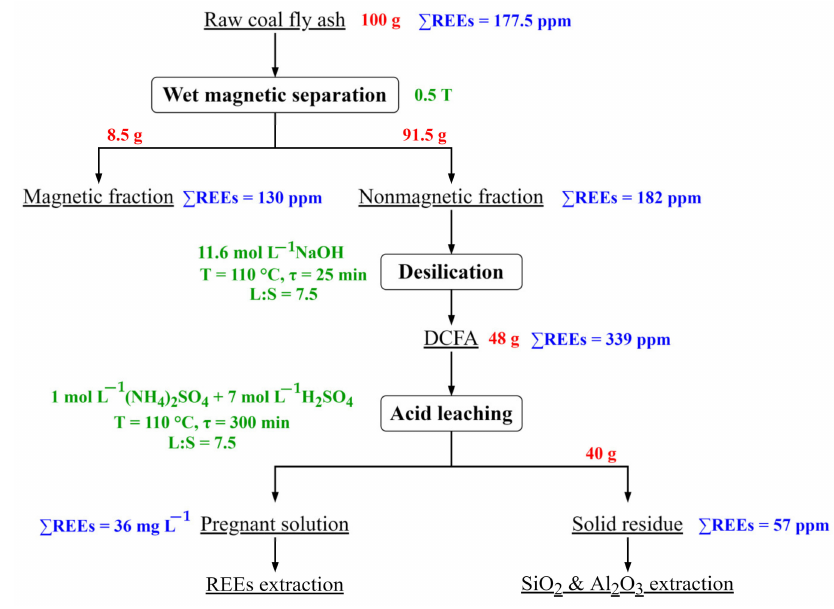
Figure 12. Flowsheet for the REEs extraction from the